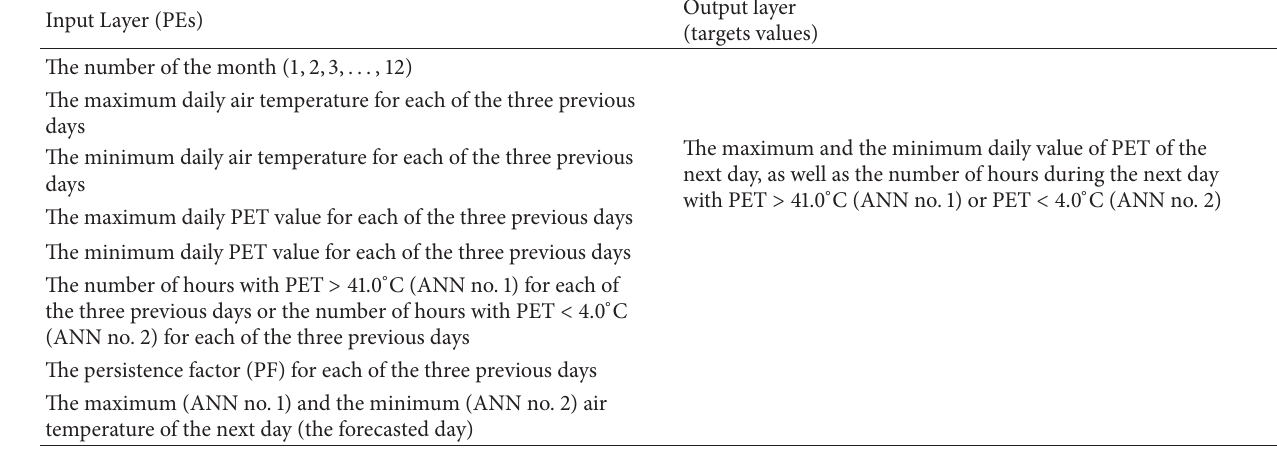
Table 2: The input PEs and the output target for the developed ANN no. 1 and ANN no. 2 forecasting models, respectively. Input Layer (PEs) The number of the month (1,2,3,...,12)